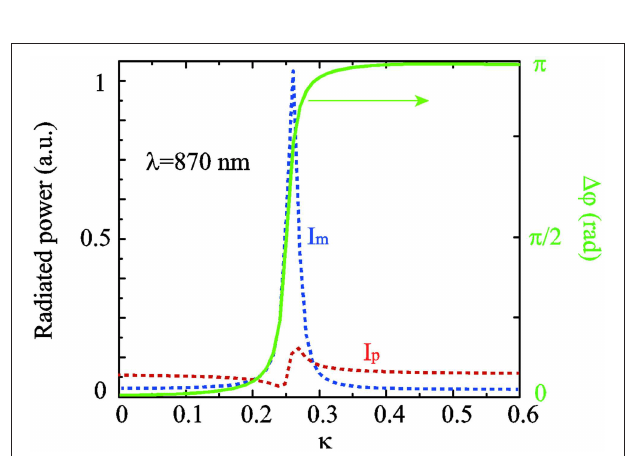
FIGURE 5 | The normalized radiated powers of ED and MD moment and their relative phase difference 1ϕ for λ = 870nm.